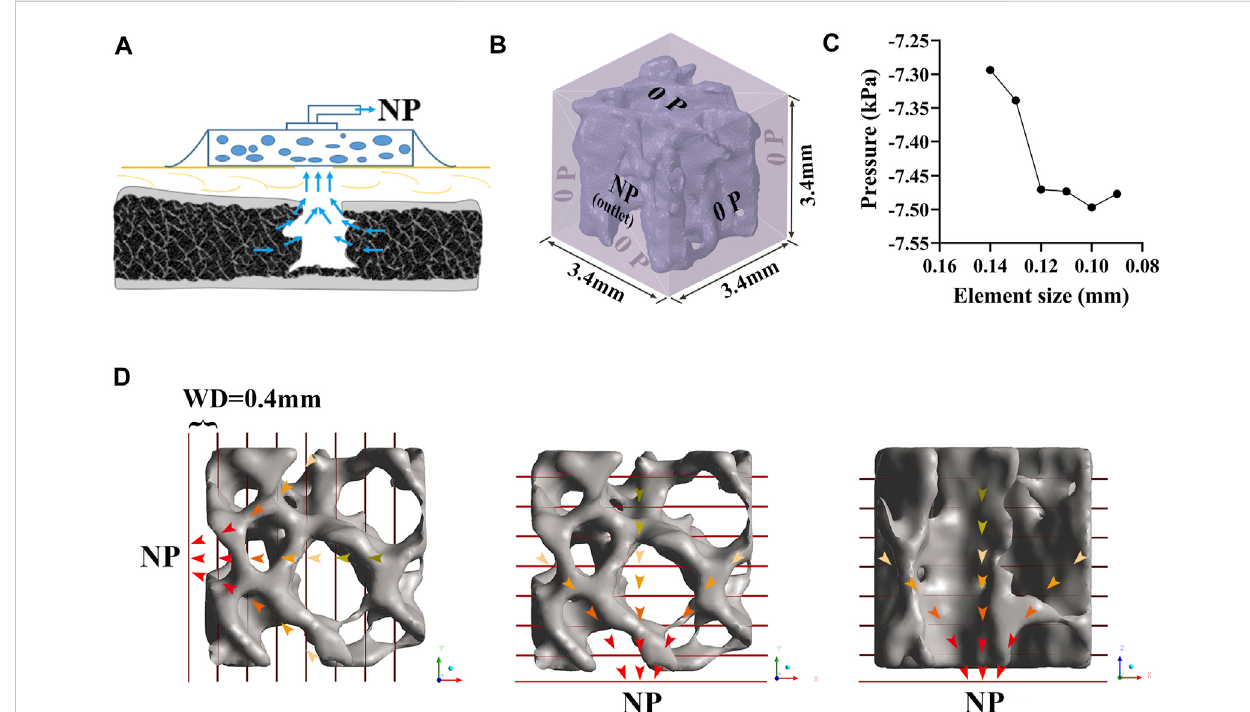
FIGURE 2 Development of CFD model of trabeculae. (A) Bone defect treated by NPWT. (B) Fluid domain and boundary condition. A 3.4 × 3.4 × 3.4 mm fl uid box represents the marrow region; one of the planes was assigned as an outlet with NP while the others were inlets with zero pressure; the trabecular bonewasconsideredrigidandhadnoslip,andthesimulatedmarrowwasassumedtobeasteady-state,laminar,andincompressibleNewtonian fl uid. (C) Convergence study for accuracy of the CFD simulation. (D) NP was applied in three directions (along the X-, Y-, and Z-axis, respectively). A series of thecross-sectional plane was placed atan interval of 0.4 mm, representing theWDfrom NP sources. Each plane ’ scontents (including pressure,velocity, and shear stress) were expressed as median (25th – 75th